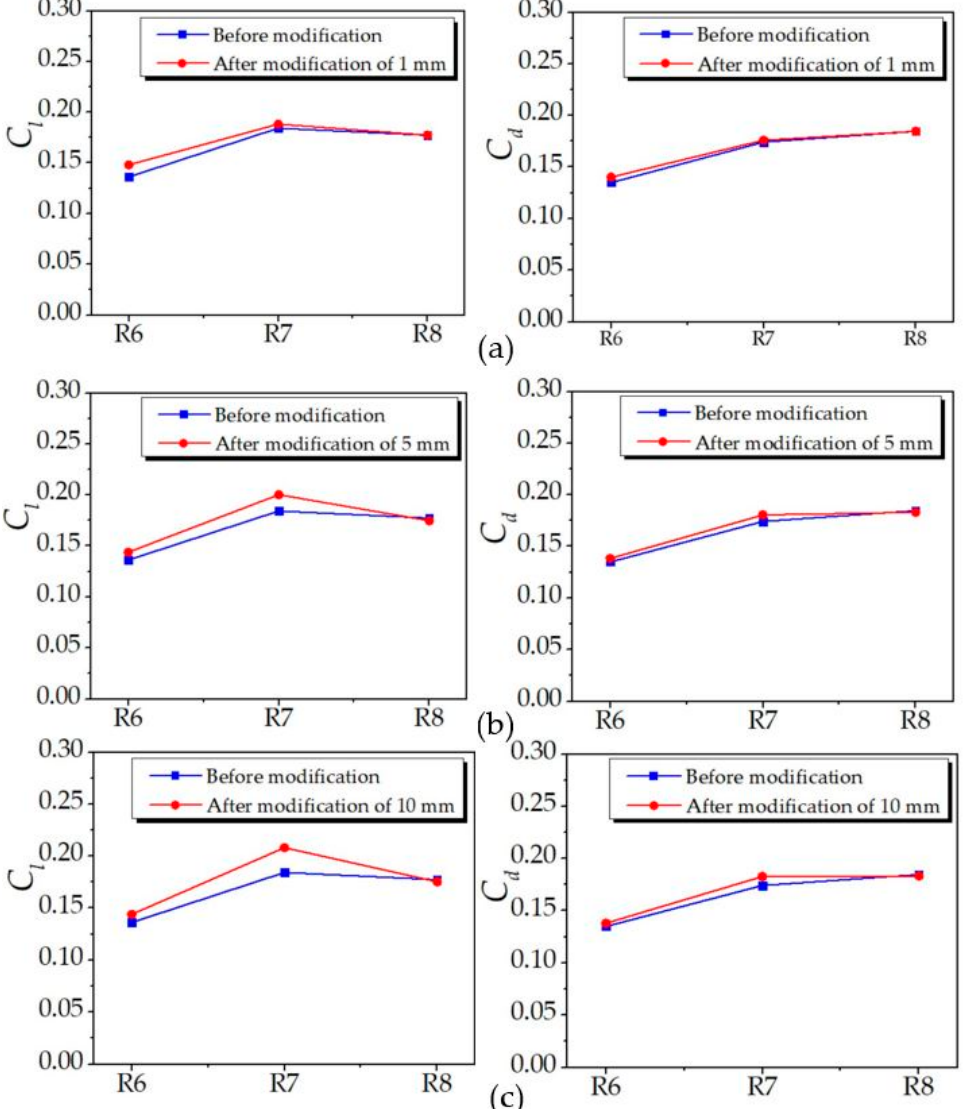
Figure 11. Lift ( C l ) and drag ( C d ) coe ffi cients of the blade in di ff erent stage after modifications of ( a ) 1 mm, ( b ) 5 mm, and ( c ) 10